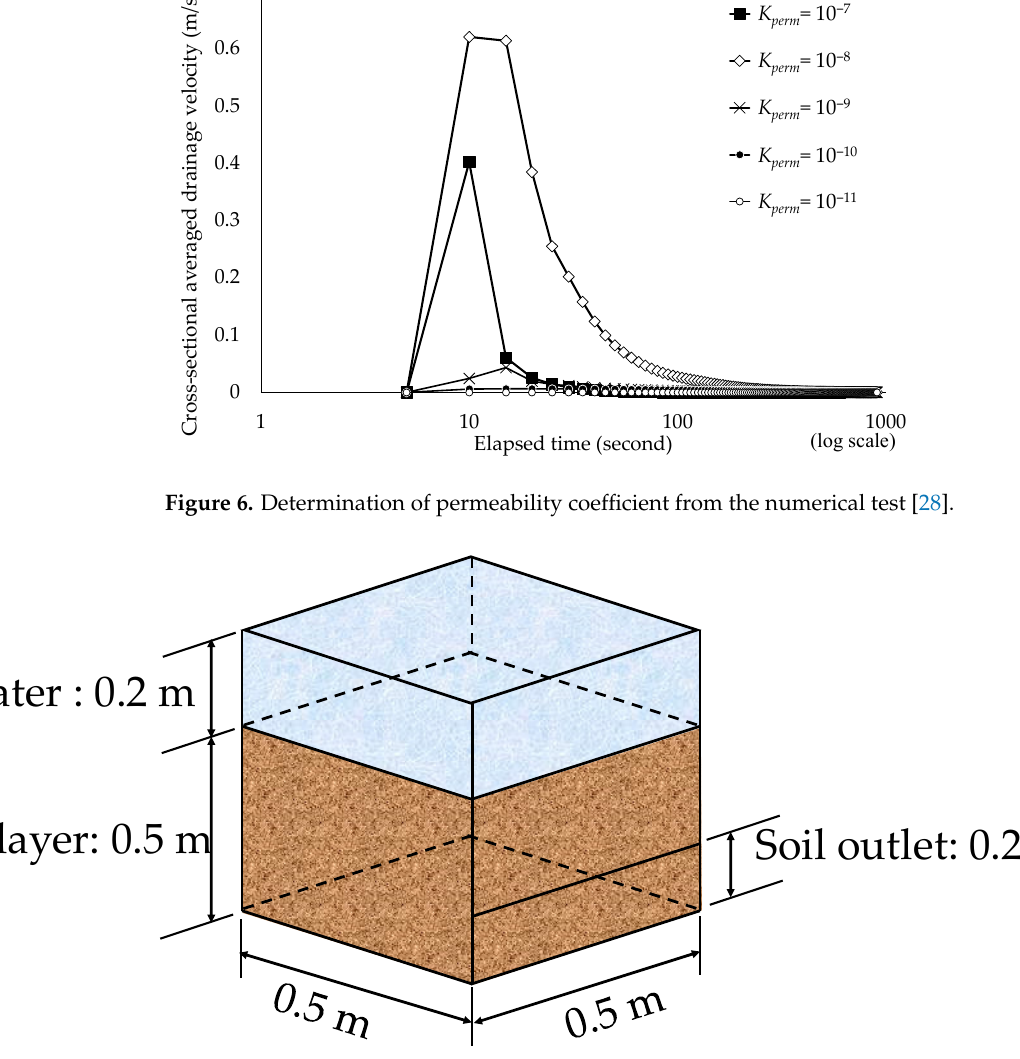
Figure 5. Flowchart of the pre-processing: definition of physical modeling and numerical parame- ters [27].